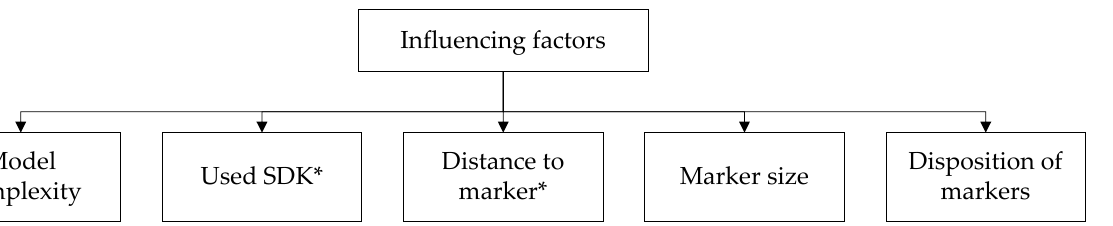
Figure 10. Distribution of markers outdoors.